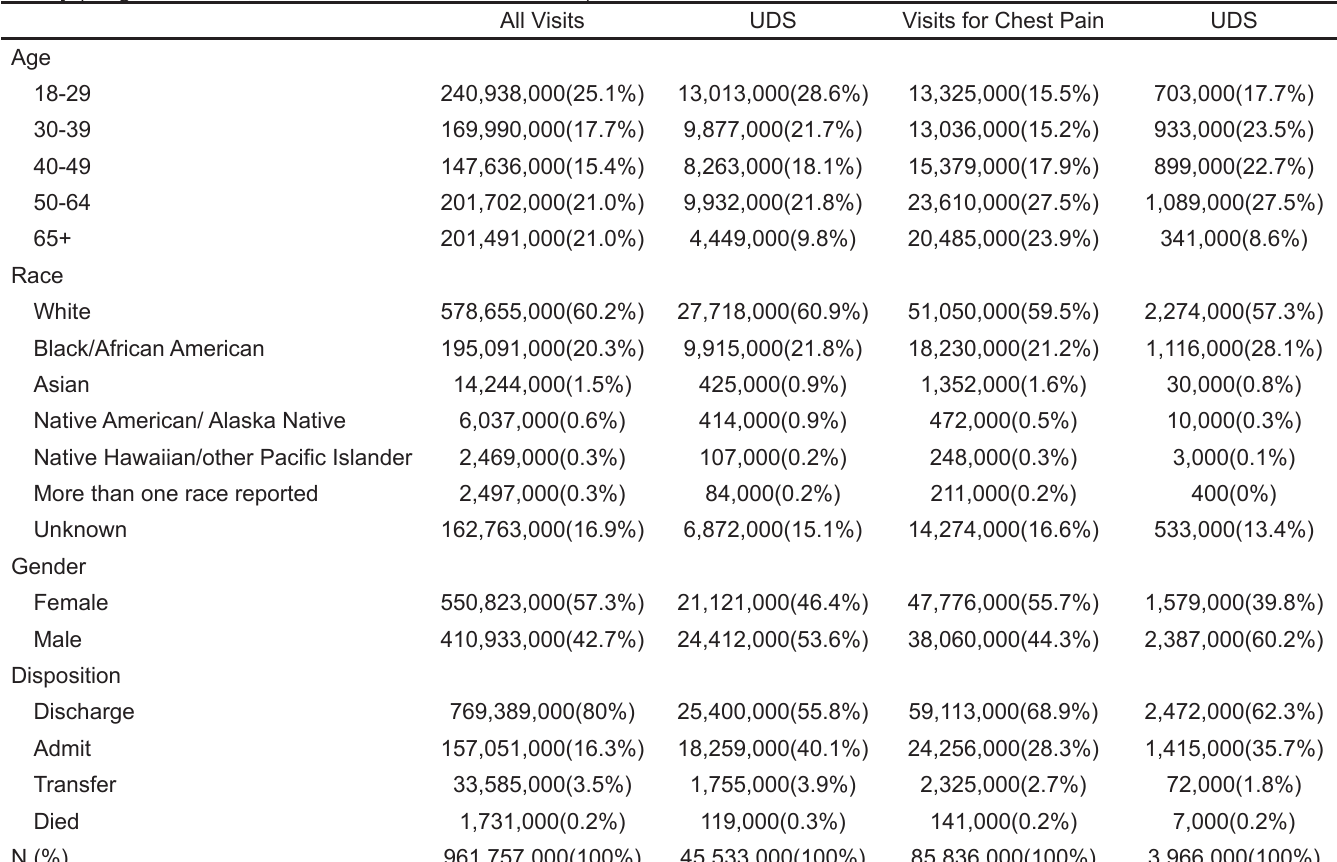
Table 1. Characteristics of emergency department visits for chest pain in the 2011-2019 National Hospital Ambulatory Medical Care Survey (weighted counts, rounded to the nearest thousand).